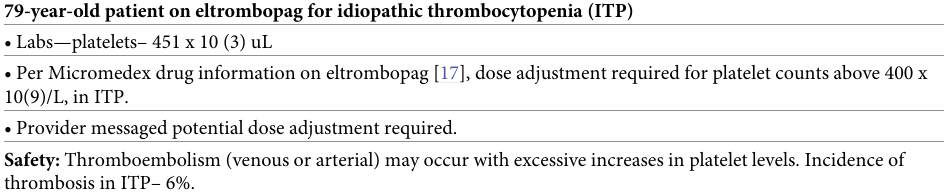
Table 3. Three case studies of accepted medication